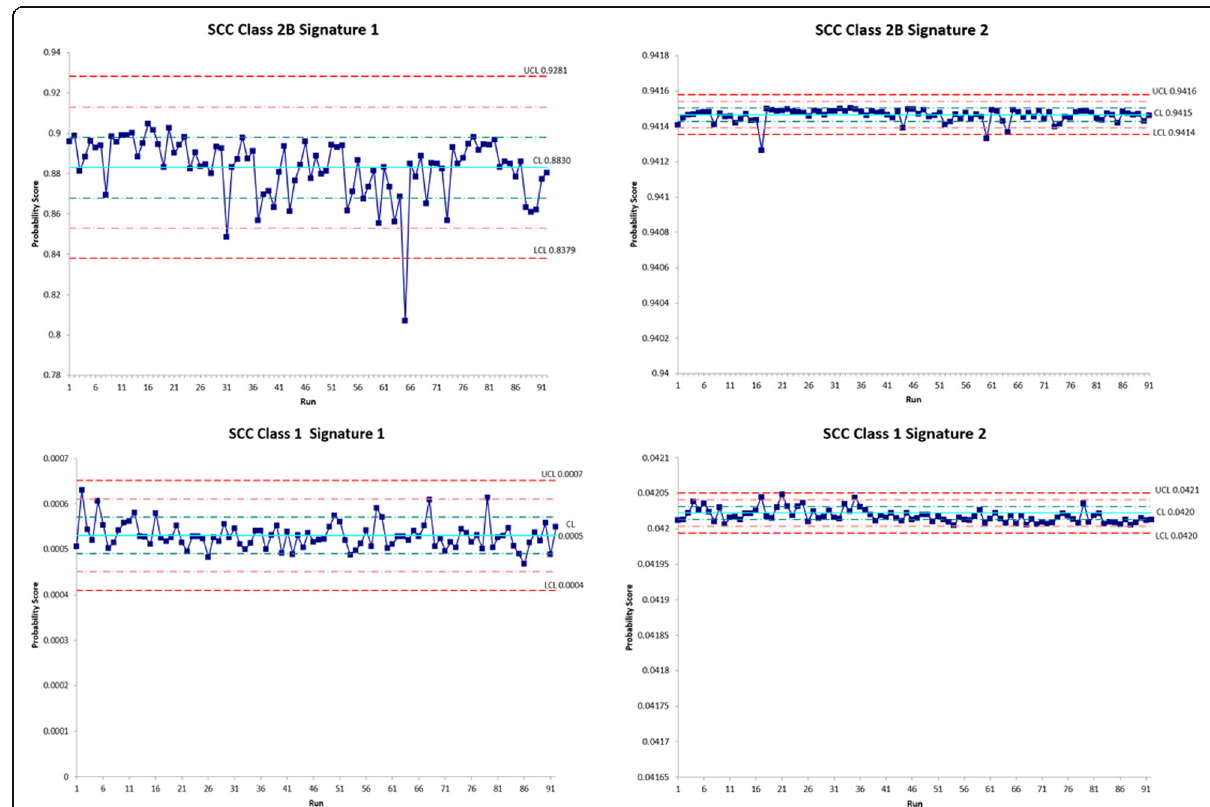
Fig. 3 A Levey-Jennings graph depicts the positive control sample probability score stability and assay robustness across multiple runs. The reproducibility of the assay performance for a Class 1 and Class 2B positive control is shown. The mean is shown as the control limit (CL); +1SD is the dashed green line; +2SD is the dashed pink line; +3SD UCL (upper control limit) is the dashed red line; − 3SD LCL (lower control limit) is the dashed red